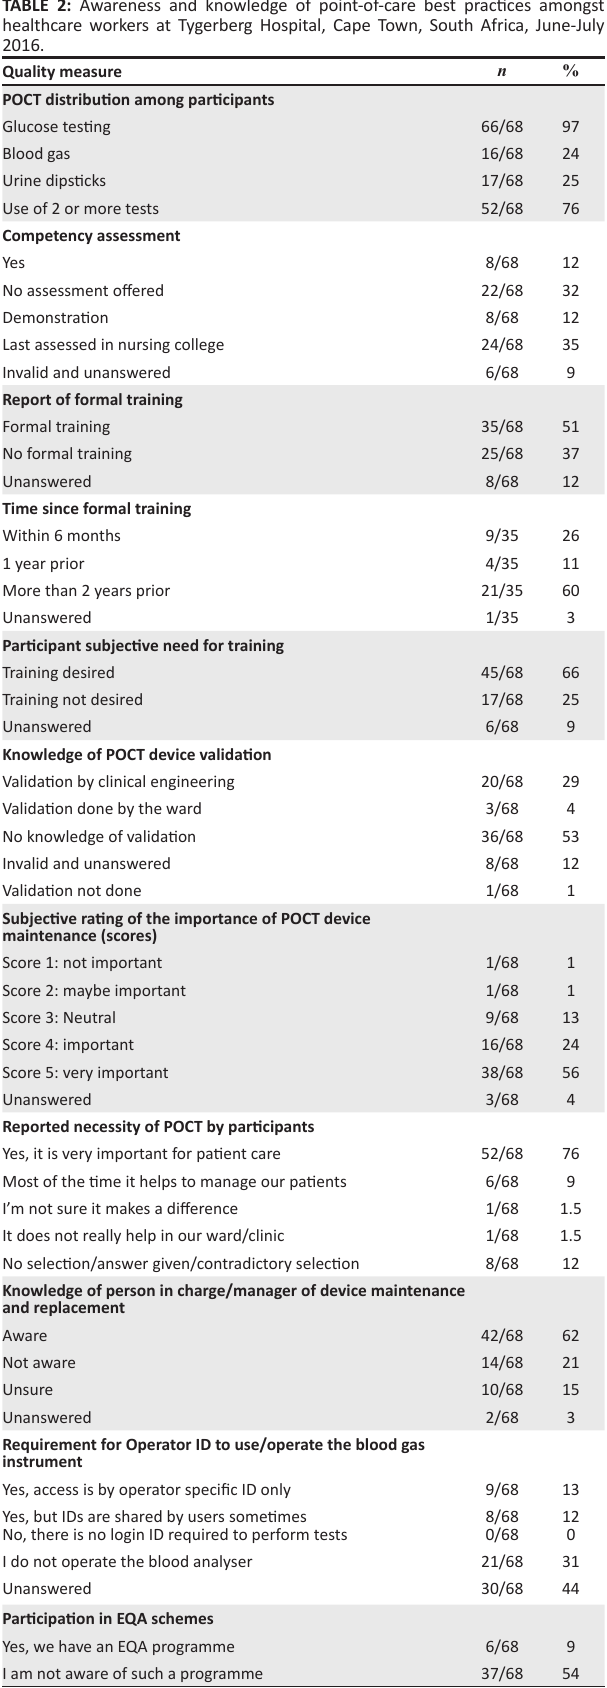
TABLE 2 (Continues...): Awareness and knowledge of point-of-care best practices amongst healthcare workers at Tygerberg Hospital, Cape Town, South Africa, June-July